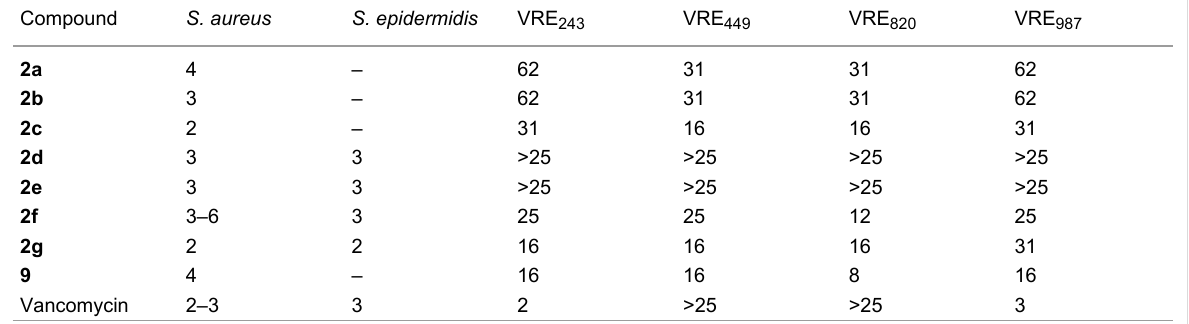
Table 1: MIC values ( μ g/mL) against S. aureus , S. epidermidis and Enterococci of the tripeptide benzyl ester derivatives 2a – g and 9 [6] as their dihy- drochloride salts. a